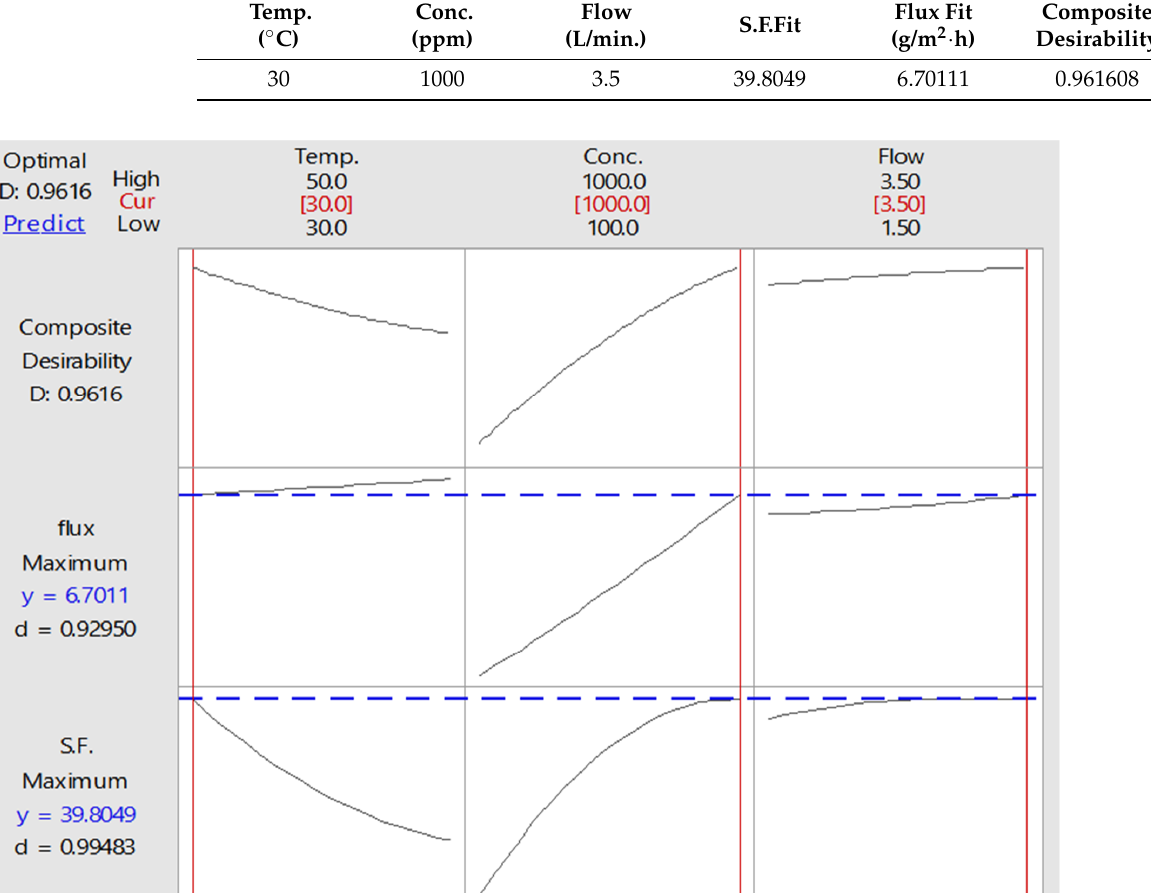
Table 8. Response optimization of benzene flux and S.F. for benzene–water solution. Temp.